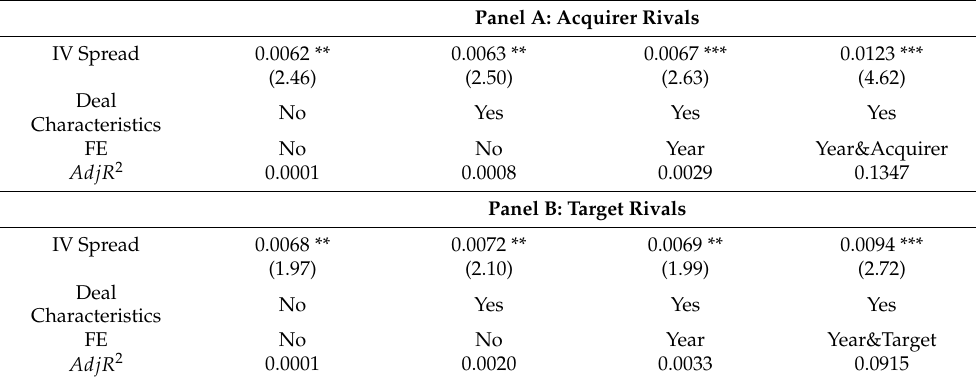
Table A2. Implied Volatility Spread and Rival Announcement CAR: